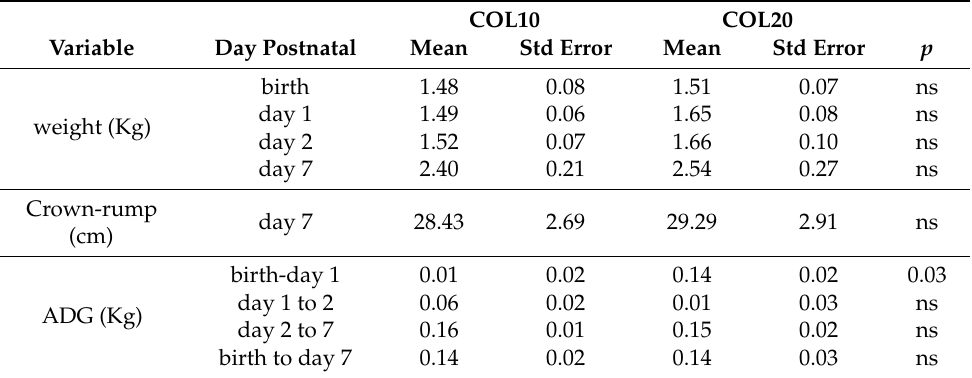
Table 1. Birth body weight and the effect of colostrum intake at a rate of 10% (COL10) and 20% (COL20) over the first 24 h after birth on weight (day 1) and average daily gain (ADG; birth to day 1), and weight and average daily gain one day following the return to birth litter (day 2 and day 1–2), weight and growth to study termination (day 7; day 2 to 7 and birth to day 7) and postnatal day 7 crown rump length.